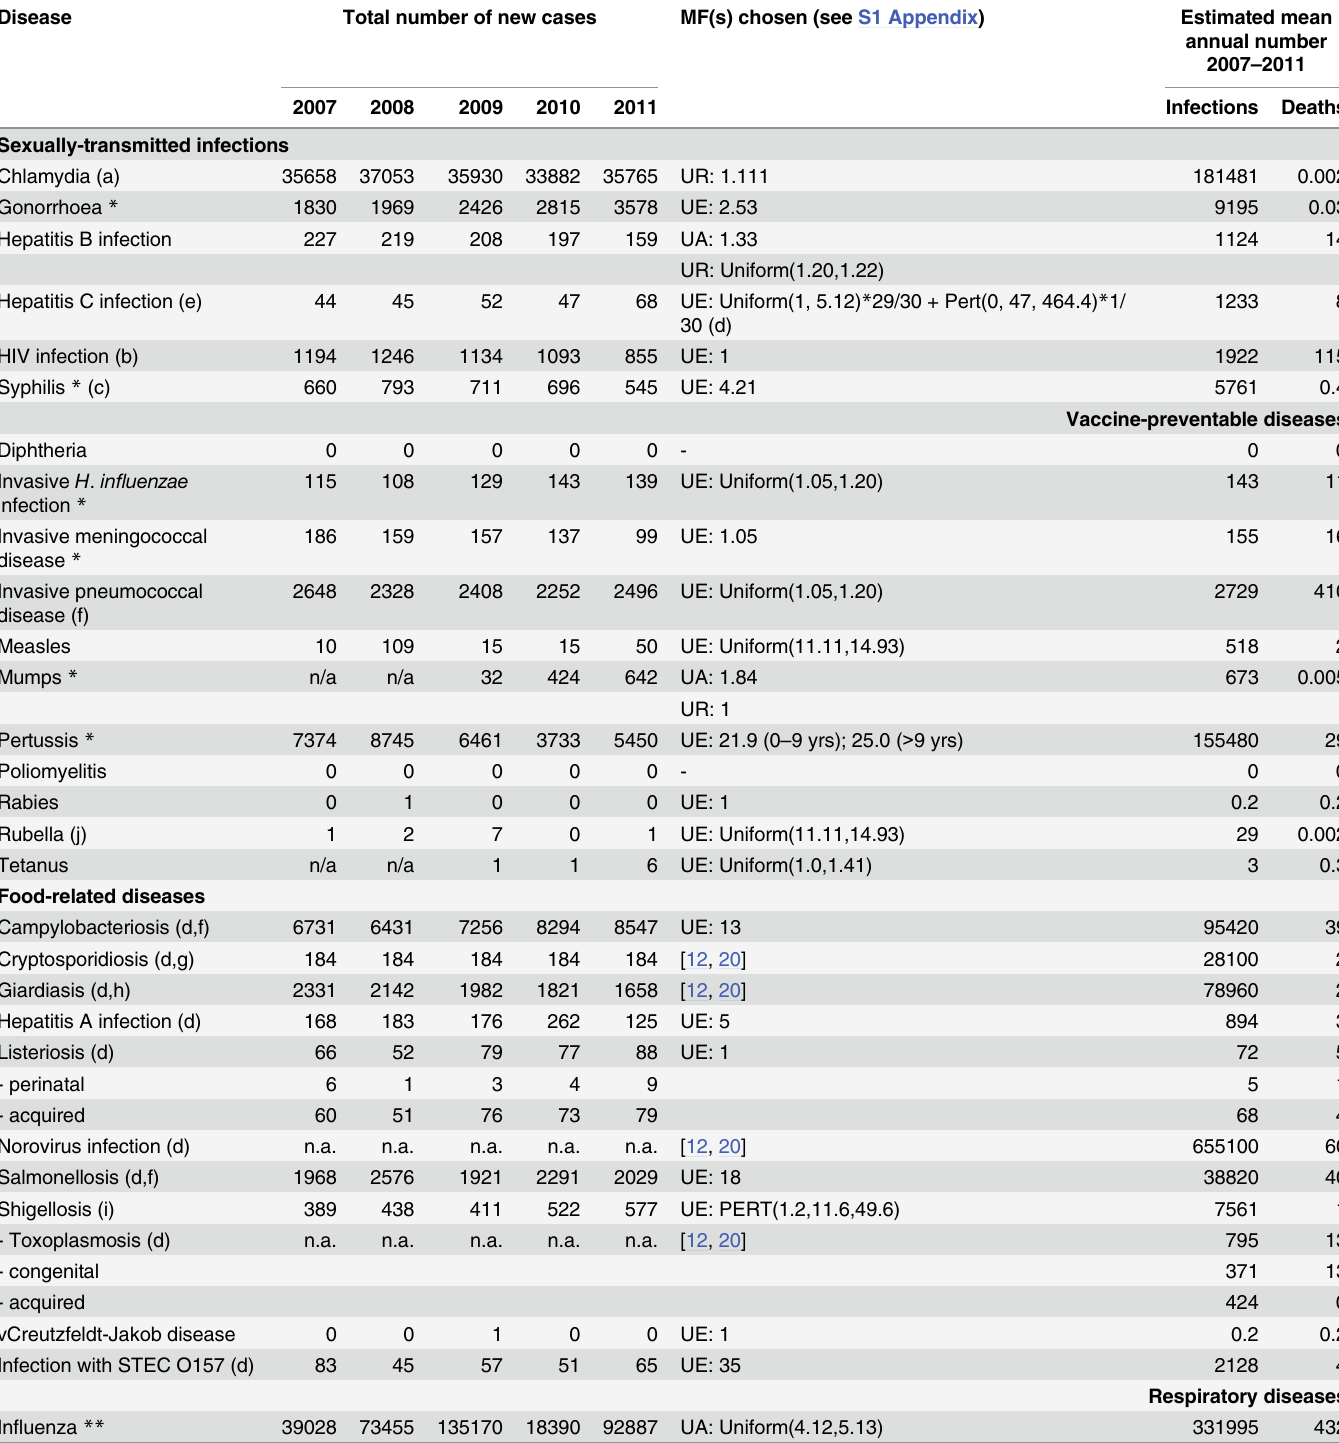
Table 1. Total number of new cases in 2007 – 2011 in the Netherlands, multiplication factors (MFs) chosen to adjust for under-estimation, and the estimated annual number of total infections and deaths (averaged over the period 2007 – 2011 and adjusted for under-estimation and the proportion symptomatic), per